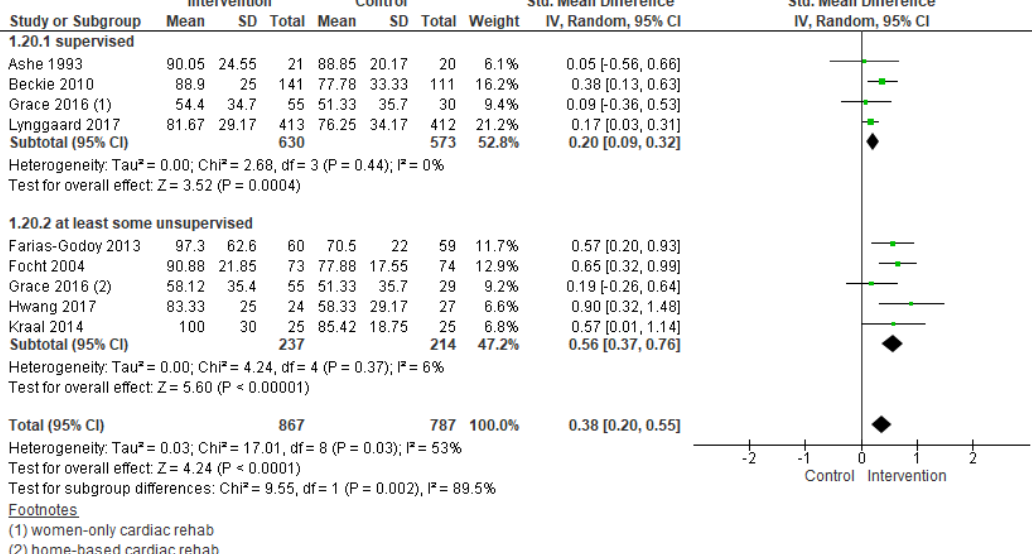
Figure 7. Forest plot for adherence—cardiac rehabilitation setting. Note: Boxes represent the standardized mean difference (SMD) for individual trials. The boxes are proportional to the weight of each study in the analysis and the lines represent their 95% confidence interval (CI). The diamond represents the pooled SMD, and its width represents its 95%.